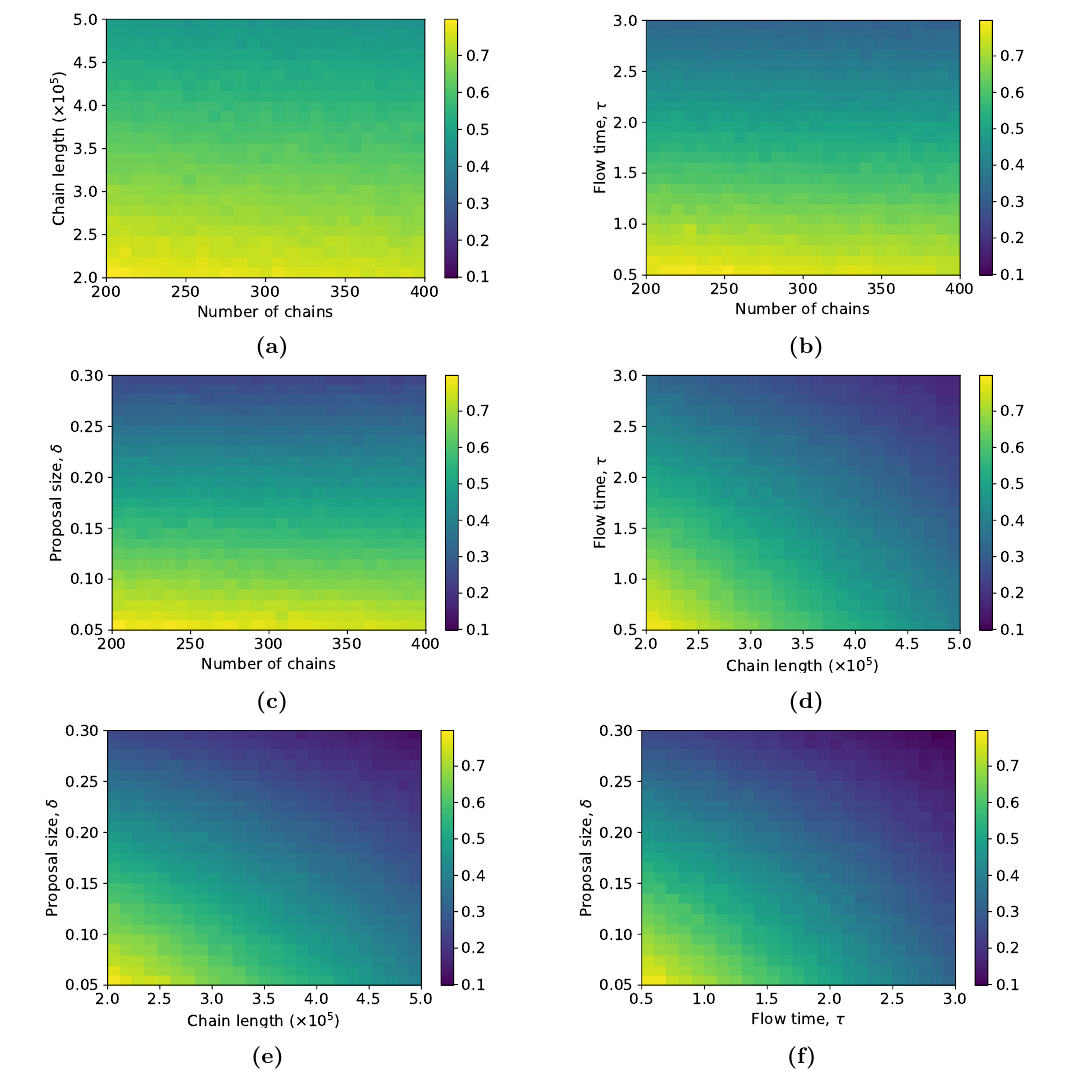
Figure 6. A comparison of the maximum error on a test correlator for various simulation param-